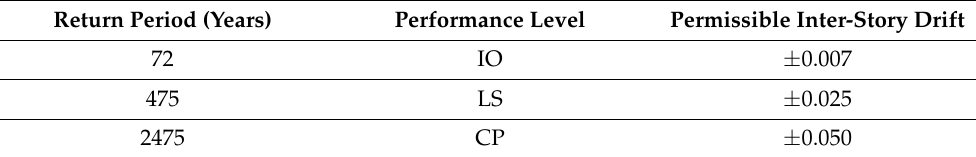
Table 5. Permissible inter-story drift for performance level (FEMA-350, 2000). Return Period